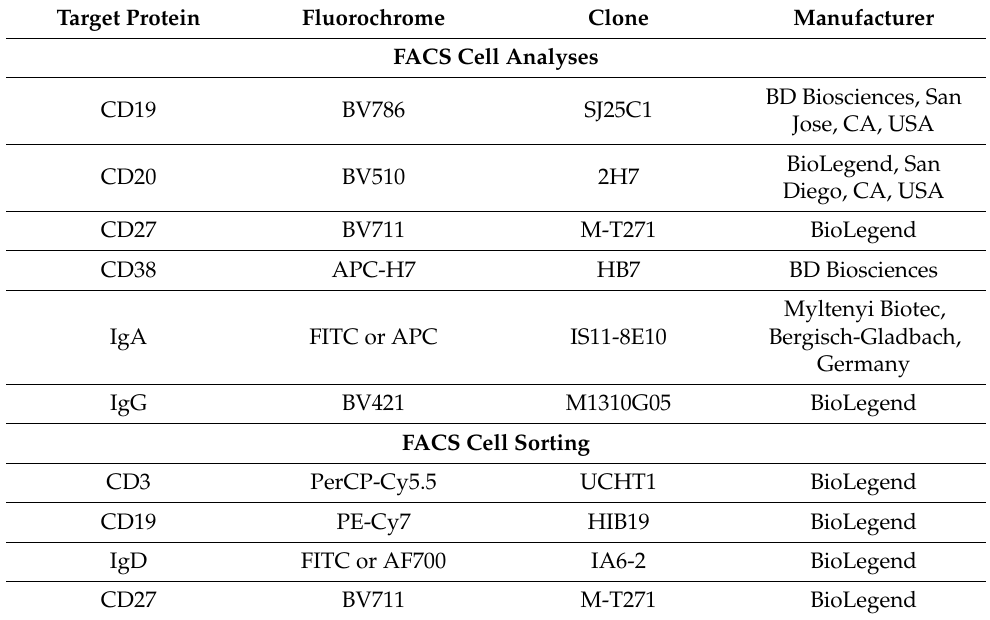
Table 2. Antibodies used for flow cytometric analyses and fluorescence activated cell sorting. Target